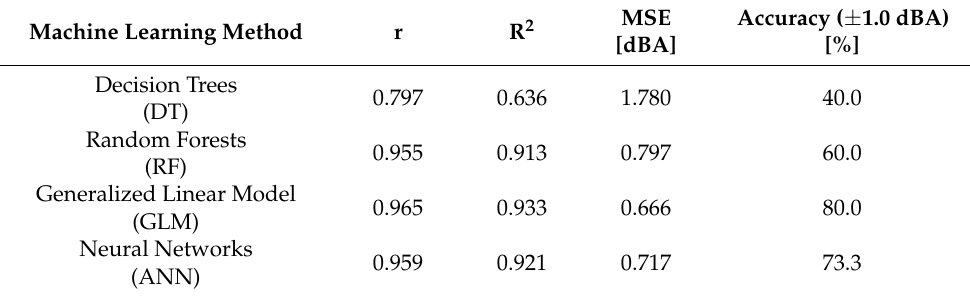
Table 4. Comparison of results for the prediction models (testing